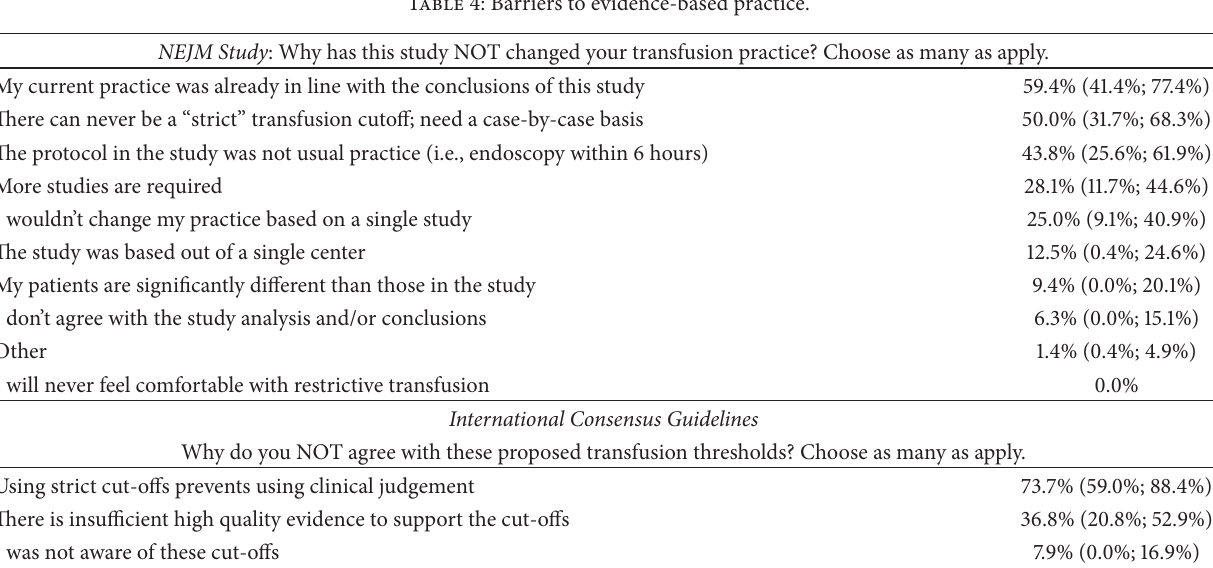
Table 4: Barriers to evidence-based practice.